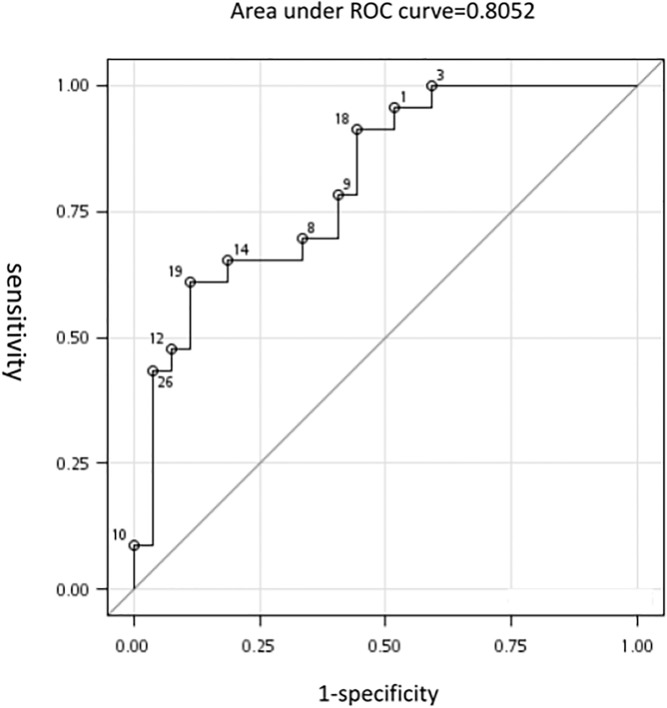
The ROC curve of nodal width for predicting HBeAg seroconversion in chronic B hepatitis with acute flare.The area under curve is 0.8052.